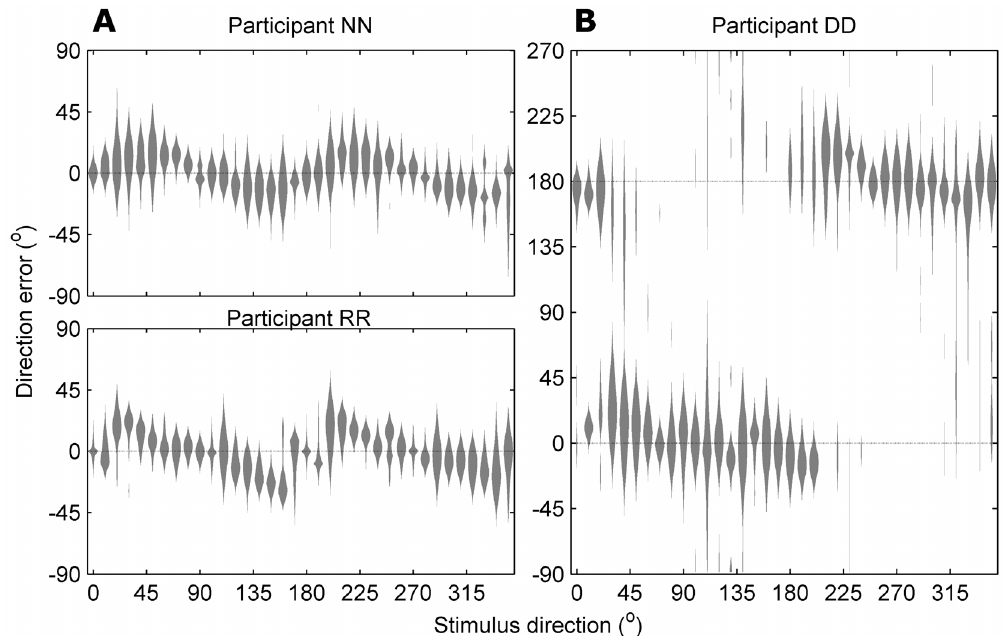
Figure 7. Individual performance. Distribution of errors in direction judgments, shown as violin plots for each stimulus direction (smoothed by adaptive-bandwidth kernel density estimation). Responses are shown for 3 observers from Experiment 2 trials with duration 160 ms (A) and 20 ms (B). Note the anisotropy in direction reports: cardinal directions tend to have more precise judgments, evident as a tighter distribution; near-cardinal directions tend to be reported as further from the cardinal axis than is true, leading to a bias in the mean error. At short viewing durations, many directions were reliably reported as 180 u from the correct direction (B).